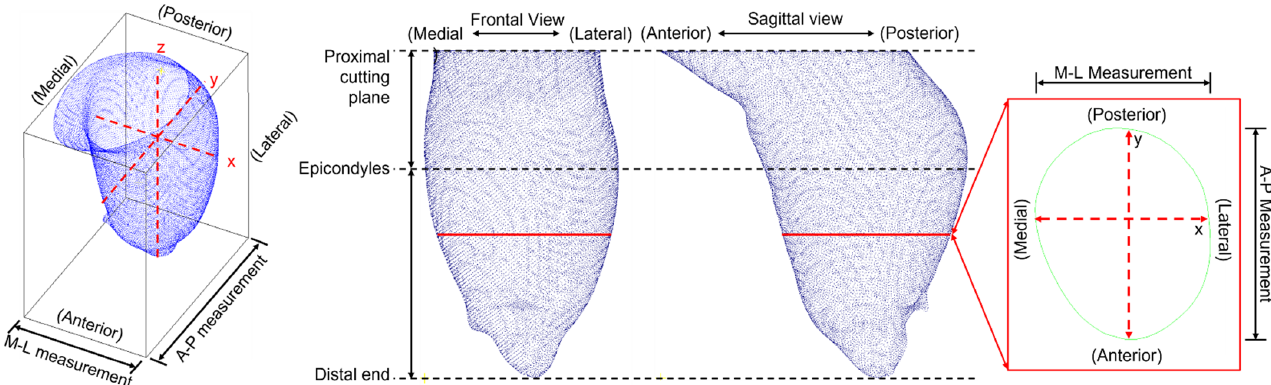
Figure 4. Each residual limb model is confined in a bounding box in the software. Then each model was sliced in the X-Y plane along the Z-axis. A slice is as shown in the red box. The cross-section area (CSA), Medial-Lateral (M-L) and Anterior-Posterior (A-P) measurement of each slice were also computed.